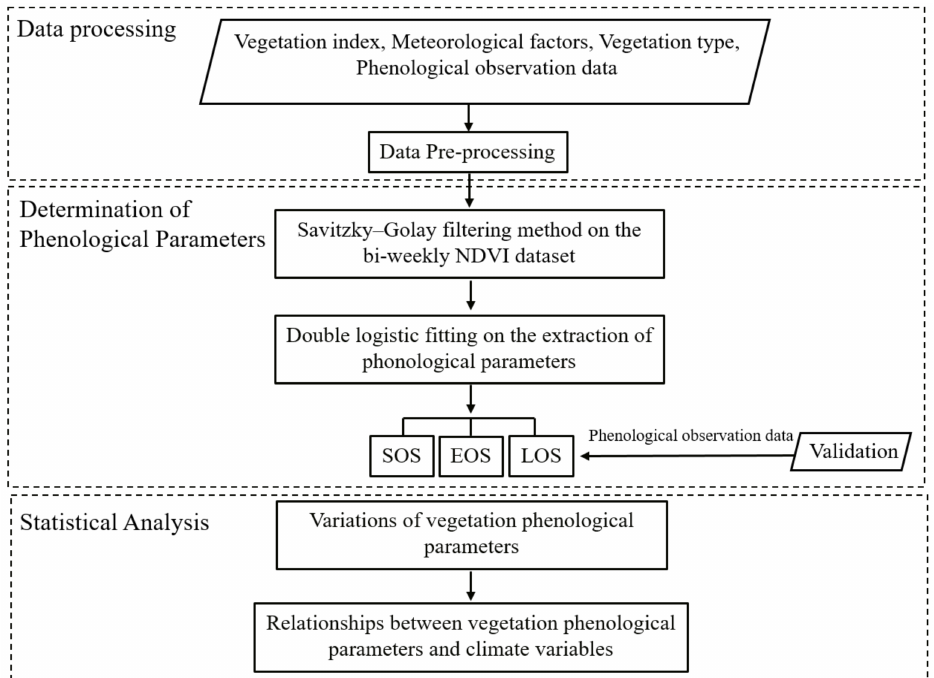
Figure 1. Flowchart of